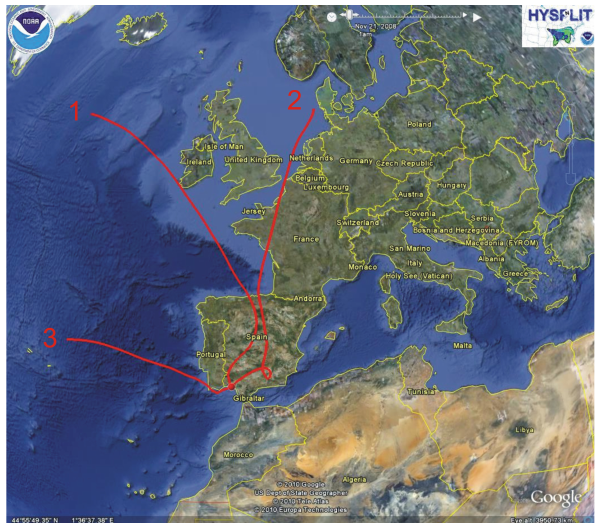
Fig. 1. Location of the measurement site with three 72h HYSPLIT back-trajectories of air masses reaching the site at 00:00 on the 24 November 2008 (1, Huelva sector), 27 November 2008 (2,continen- tal sector) and 7 December 2008 (3, Atlantic